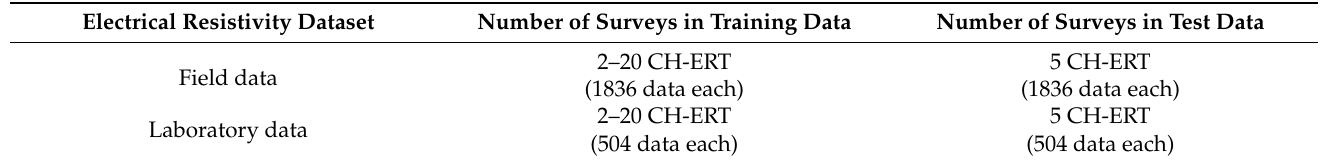
Table 1. Description of the two datasets used in the present manuscript for testing Vector Autoregressive (VAR) and Recurrent Neural Network algorithms (RNN).